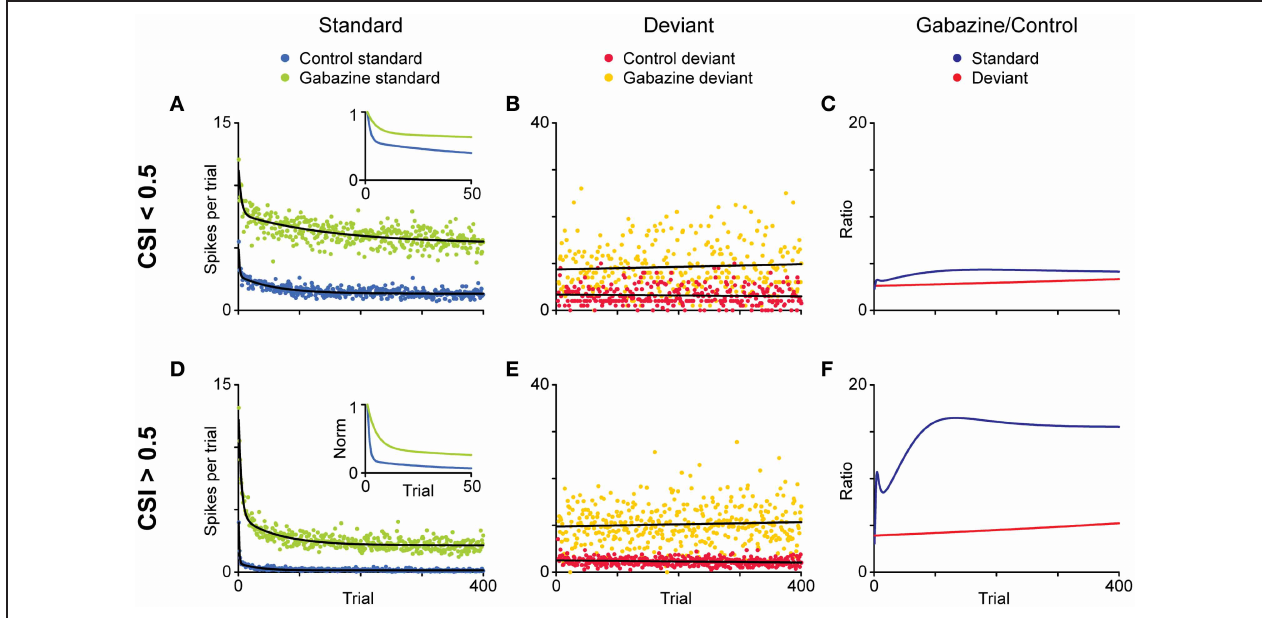
the control condition and during application of gabazine was compared. The data for standard stimuli were fitted by a double exponential function (black lines), and the data for deviant stimuli, by a linear function. The insets show a magnified view of the normalized functions during the first 50 trials. Note the different ordinate scales for standard and deviant. (C,F) Ratio of gabazine/control for each type of stimulus during gabazine application. Reproduced from Pérez-González et al. (2012).